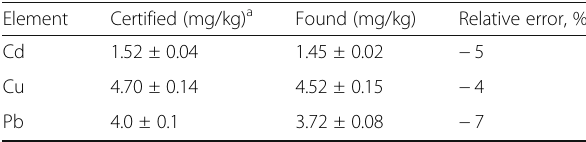
Table 2 Determination of Cd, Cu, and Pb in (SRM-1573a tomato leaves) reference material